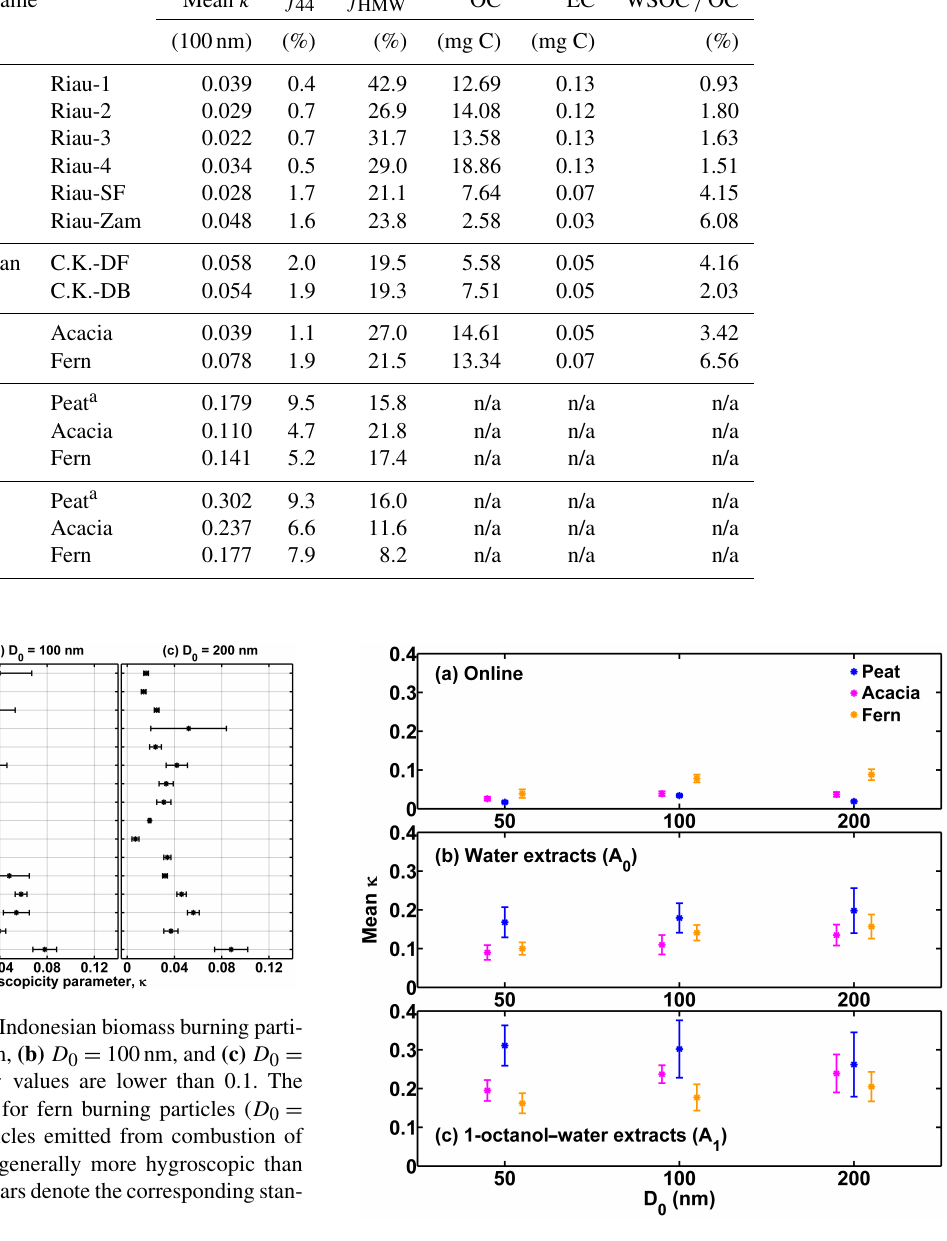
Figure 4. Comparison of κ values for (a) online, (b) water ex- tracts ( A 0 ), and (c) 1-octanol–water extracts ( A 1 ). The data for peat (Riau-4), acacia, and fern are shown. Indonesian peat burning parti- cles are almost non-hygroscopic for online data, while their water- soluble organic fractions are highly hygroscopic.